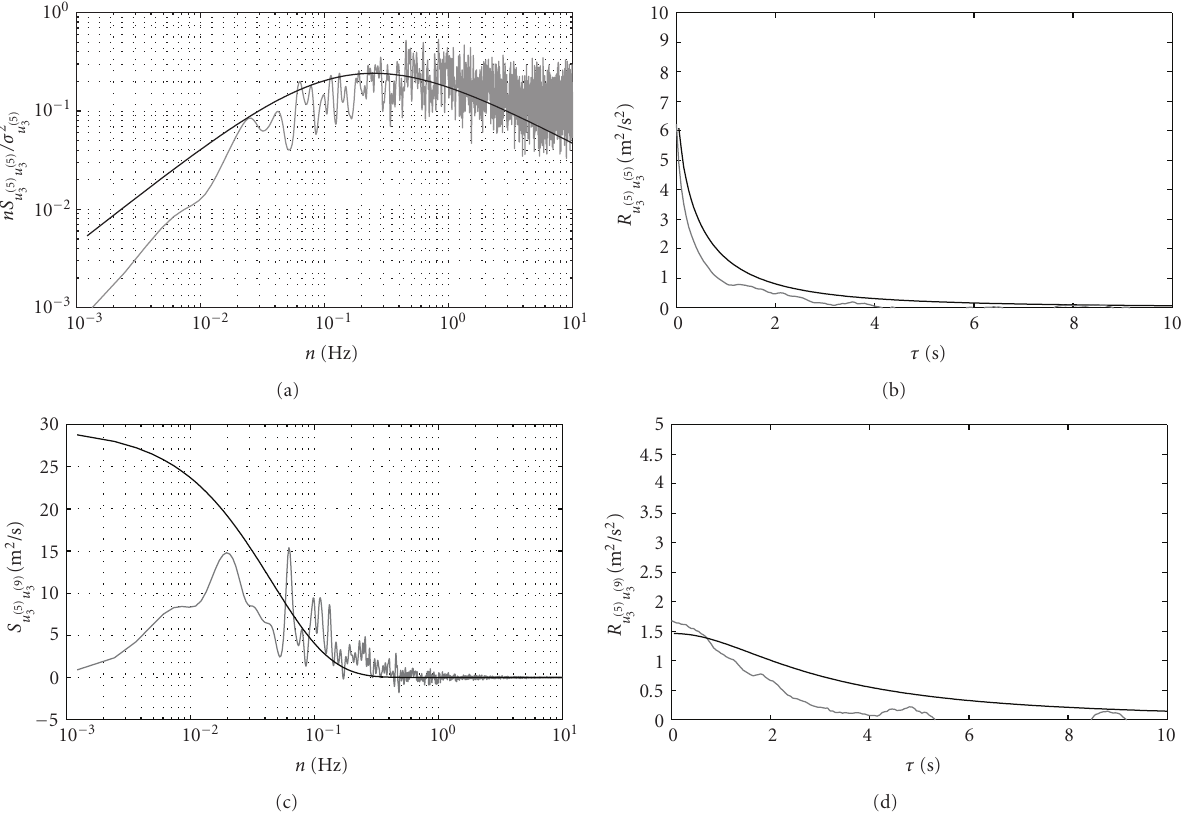
Figure 10: Example 1 using AR method (black lines denote target functions, gray lines denote numeric approximations): autospectrum of across-wind velocity at point 5 (a); corresponding autocorrelation function (b); cross-spectrum between across-wind velocities at points 5 and 9 (c); corresponding cross-correlation function